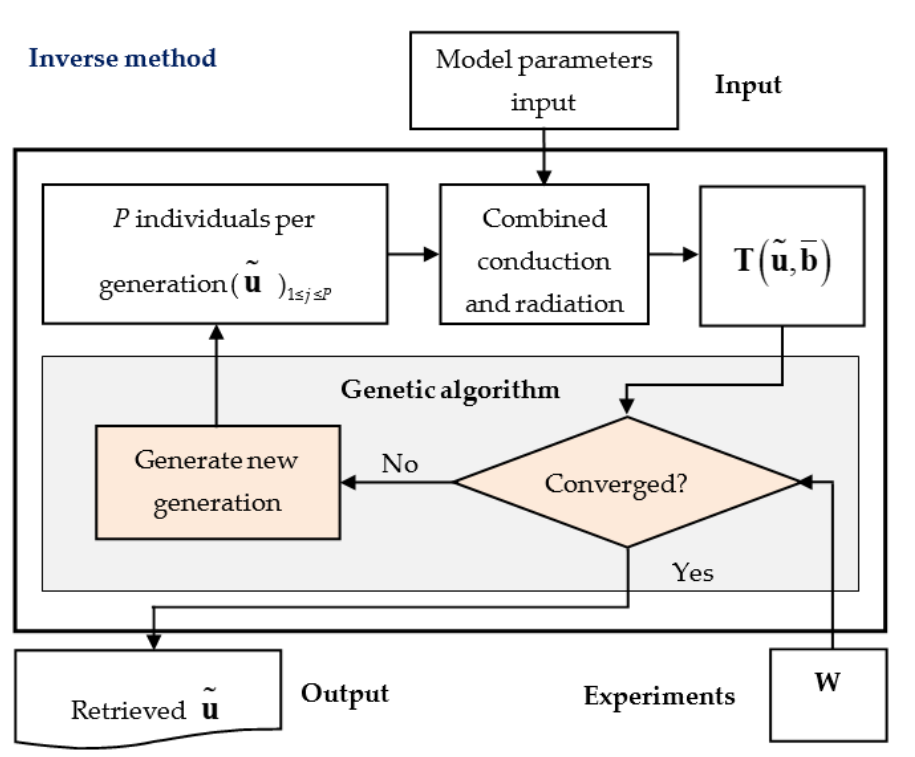
Figure 2. Block diagram of the inverse method.